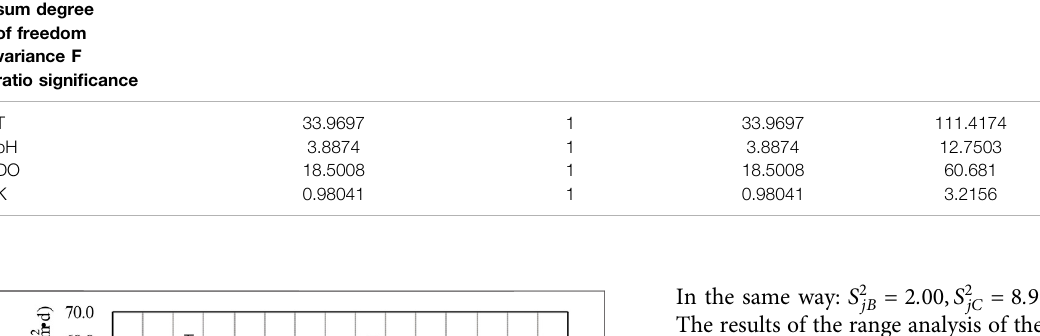
TABLE 2 | Signi fi cant test results of the multiple linear regression coef fi cients of the TN release strength from the sediments. Variance source deviation square